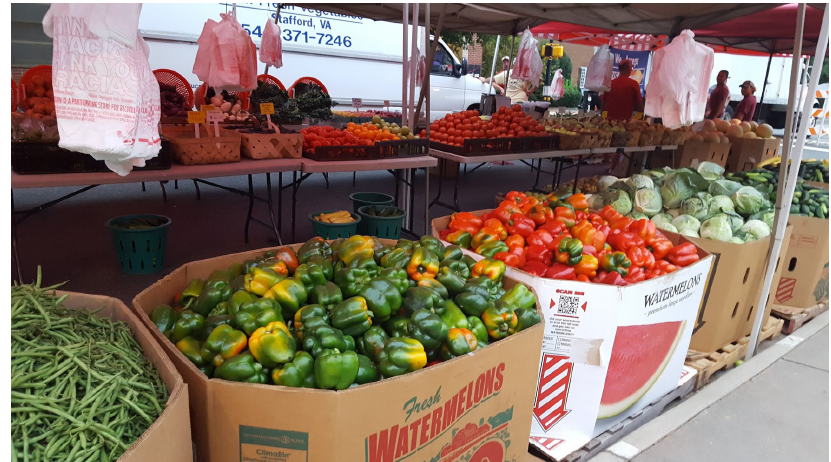
Figure 2 . Large bins of produce at the Fredericksburg, Virginia Farmers Market, 2016. Photo by